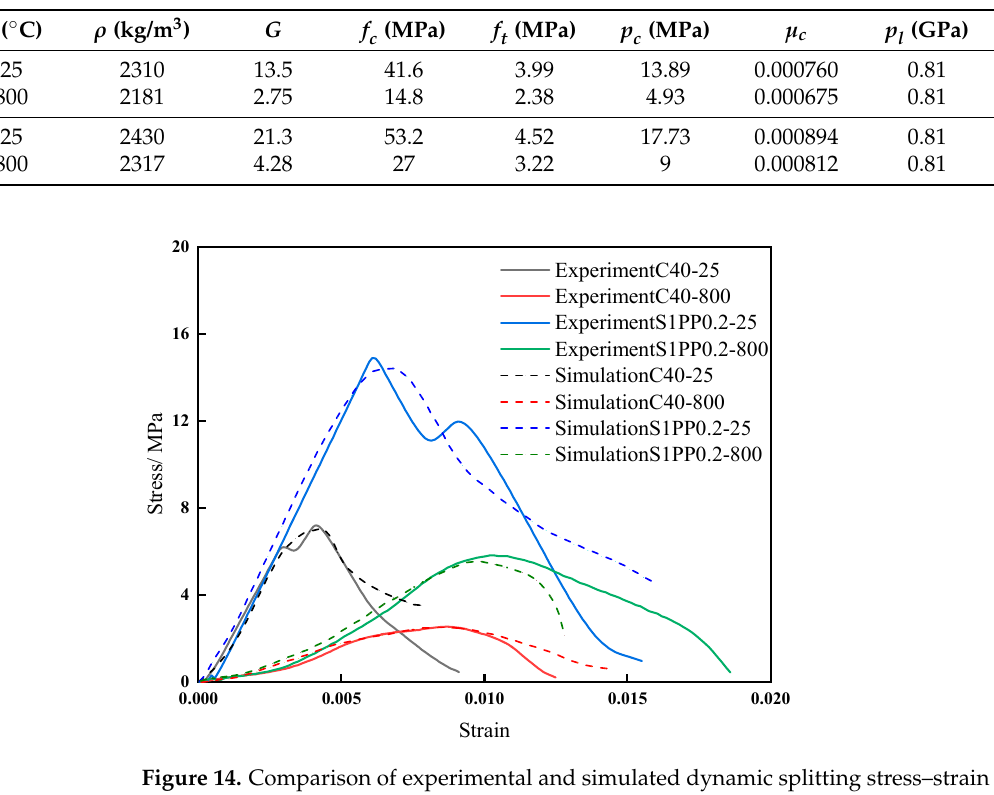
Table 6. Parameters of the concrete HJC material model.